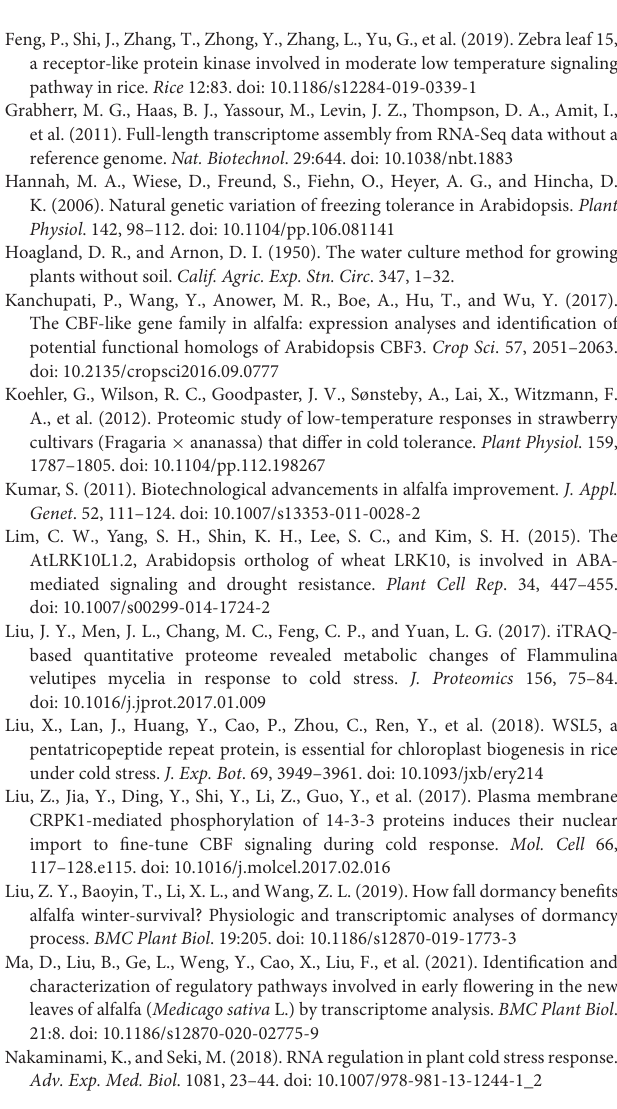
Supplementary Figure 2 | MapMan display of the coordinated changes in the expression levels of genes involved in receptor-like kinase in dormancy (D) and non-dormancy (ND) genotype alfalfa under LT conditions. Shown are DEGs in (D + LT)/D (A) and (ND + LT)/ND (B) under lower temperature condition. Squares represent DEGs, red and blue indicate up- and downregulated genes, respectively. Supplementary Figure 3 | MapMan display of the coordinated changes in the expression levels of genes involved in RNA and protein synthesis in dormancy (D) and non-dormancy (ND) genotype alfalfa under LT conditions. Shown are DEGs in (D + LT)/D (A) and (ND + LT)/ND (B) under LT condition. Squares represent DEGs, red and blue indicate up- and downregulated genes, respectively. Supplementary Table 1 | qRT-PCR validation of selected DEGs identified by RNA-seq in dormancy (D) and non-dormancy (ND) genotype alfalfa under lower temperature (LT) condition. Supplementary Table 2 | Differentially expressed genes in dormancy (D) and non-dormancy (ND) genotype alfalfa under lower temperature (LT) condition. Supplementary Table 3 | Mapman pathway enrichment analysis of DEGs in dormancy (D) and non-dormancy (ND) genotype alfalfa under lower temperature (LT)